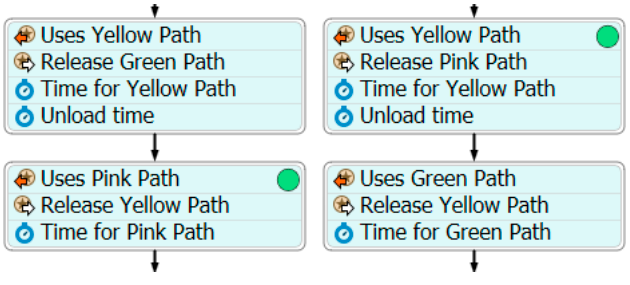
Figure 23. Deadlock represented in FlexSim.